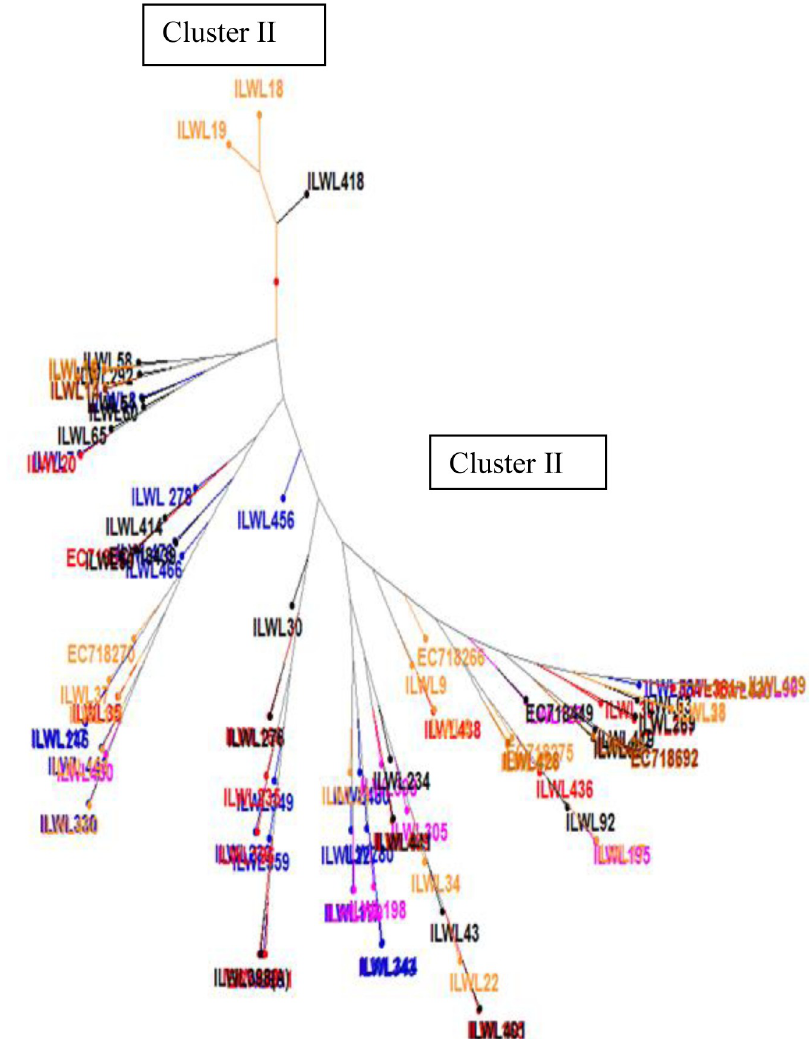
Fig 2. Hierarchical clustering of wild lentil accessions based on quantitative data analysis. Syria; ILWL18 and ILWL19 ( L . nigricans ) from France and Spain, respectively. Cluster II con- tains all remaining accessions was further divided into A and B clusters. Bifurcation of Cluster A resulted into two sub clusters AI and AII, where sub cluster AI was occupied by L . ervoides accessions ILWL58 and ILWL292 from Turkey; L . nigricans accessions ILWL16 from Alpes Cote d’ Azur and ILWL15 from France; and ILWL14 and ILWL15 of L . lamottei from France. Sub cluster AII grouped ILWL7 and ILWL8 of L . orientalis from Turkey; ILWL51, ILWL60 and ILWL65 of L . ervoides including first from Montenegro and other two from Turkey; and ILWL20 of L . odemensis from Palestine. Cluster B was occupied by two sub clusters BI and BII, each of which were further divided into two groups a, b and c, d, respectively. Group d further formed outgroups (d1 and d2) and finally clutches (d2a and d2b). As Cluster II grouped sub- clusters were occupied by accessions from different wild lentil species belonging to different countries of origin, they showed highest diversity (S1 Table). Euclidean dissimilarity matrices varied from 6.01 between ILWL429 ( L . lamottei ) from Spain and ILWL90 ( L . tomentosus )